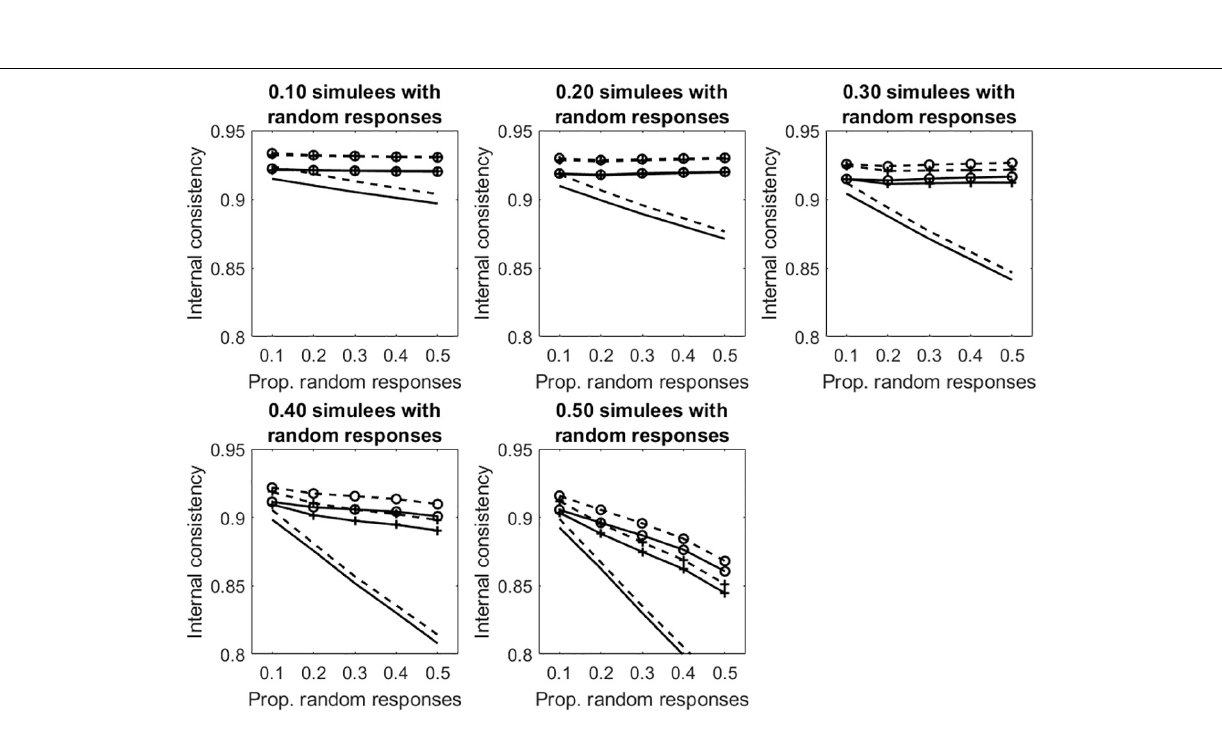
FIGURE 6 | Average internal consistency for the different proportions of simulees with random responses and the different proportions of dichotomous items with random responses. The solid lines represent KR20, the dashed lines represent R. The unmarked lines represented the full, uncleaned data sets. The +-marked lines represent infit-cleaned data sets. The o-marked lines represent the outfit-cleaned data sets.